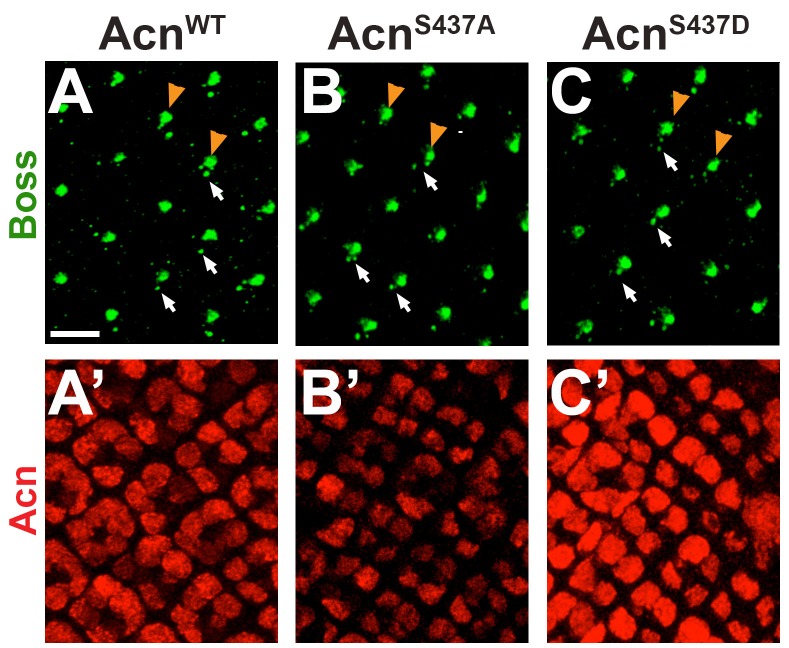
AcnS437A and AcnS437D support normal Sevenless-mediated Boss endocytosis.Micrographs of AcnWT (A), AcnS437A (B), or AcnS437D (C) larval eye discs stained for Boss and Acn. In eye discs that completely lack acn function, the Boss ligand cannot be detected in R7 cells (Haberman et al., 2010). Similar to other regulatory mutants altering the level of Acn protein (Nandi et al., 2014), AcnS437A and AcnS437D mutants displayed no change in the uptake of the Boss ligand from the R8 surface (yellow arrowheads) into the stereotypical Boss-positive endosomes within R7 cells (arrows). Scale bar: 5 µm.